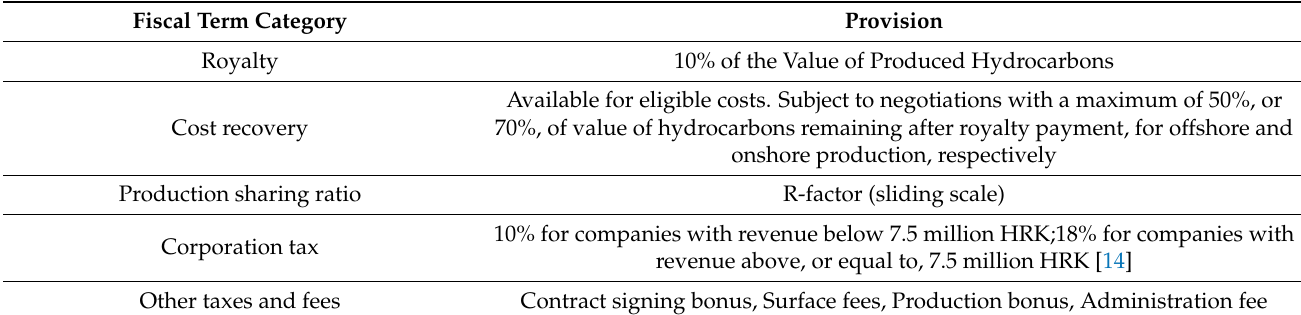
Table 1. Fiscal terms of exploration and production of hydrocarbons in the Republic of Croatia.